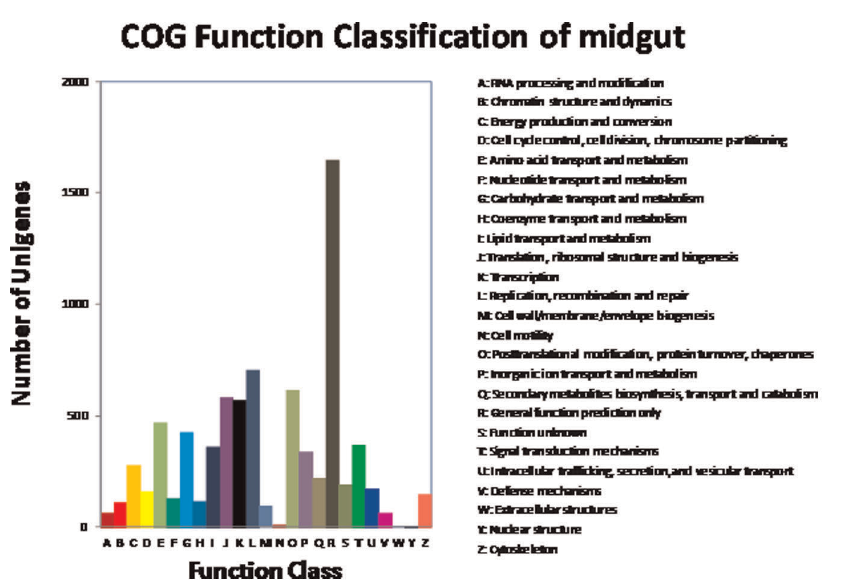
Figure 2. Histogram presentation of clusters of orthologous groups classification. Out of 345,905 nr hits, 10,967 sequences have a COG classification among the 25 categories.